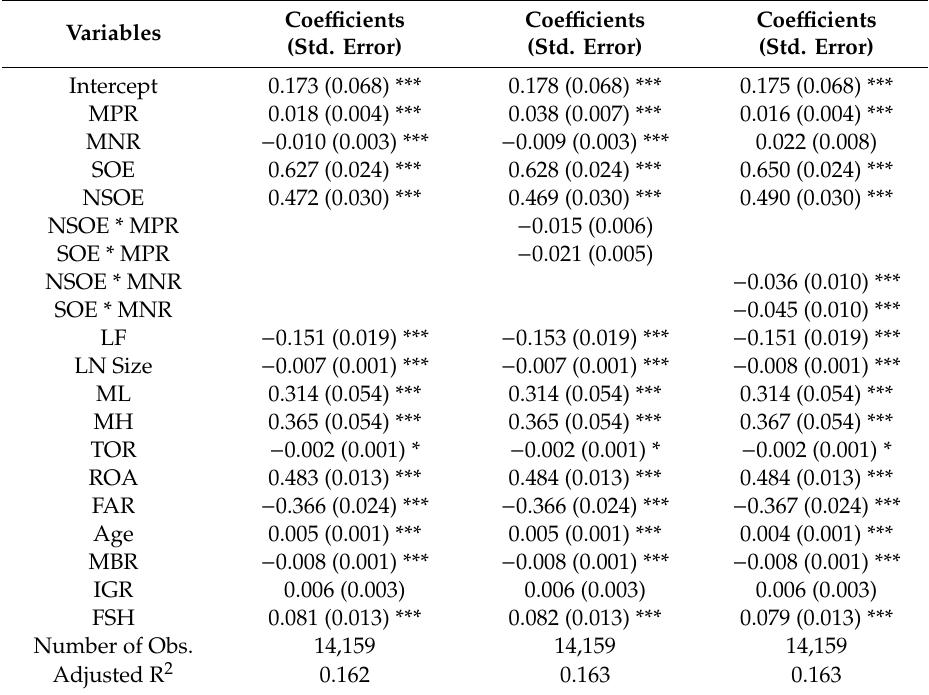
Table6. Interaction between Government and Non-Government with the relationship of MPR and